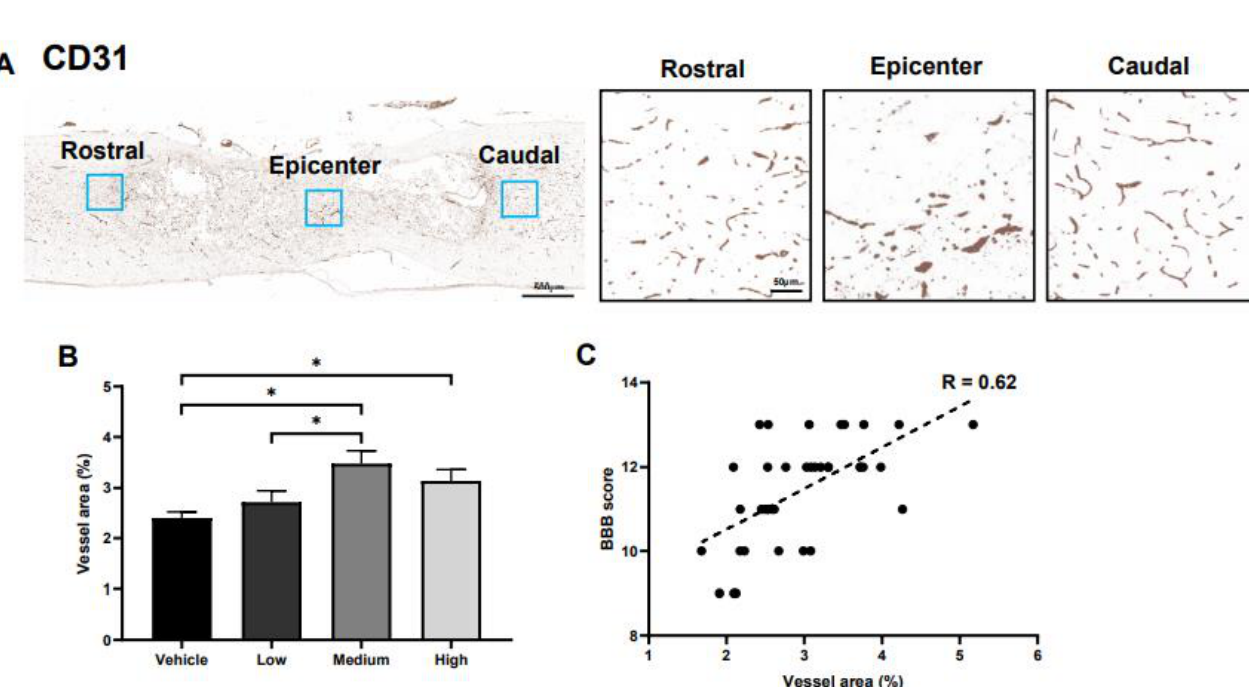
Figure 6. Effects of ahMNCs transplantation on angiogenesis. ( A ) Immunohistochemistry against CD31. Scale bar = 500 and 50 µ m in the lower and higher magnifications, respectively. ( B ) The areas with CD31-positive vessels were quantified and compared. Scale bar = 400 and 50 µ m in the lower and higher magnifications, respectively. ( C ) Correlation between the relative area and BBB score revealed a significant positive relationship between these parameters. Height = Average, Error bar = Standard Error. *, P < 0.05.